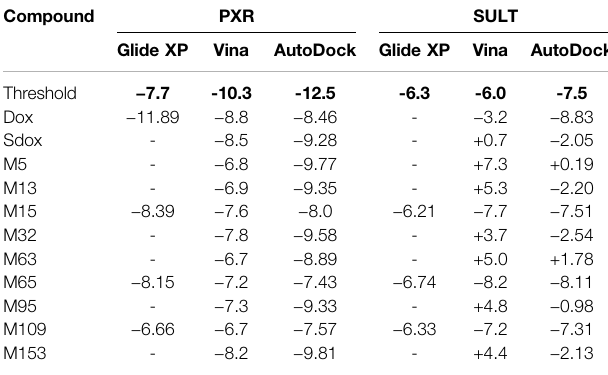
(PXR, PDB ID:1m13) and sulphotransferase (SULT, PDB ID: 2a3r) (kcal/mol). Compound PXR